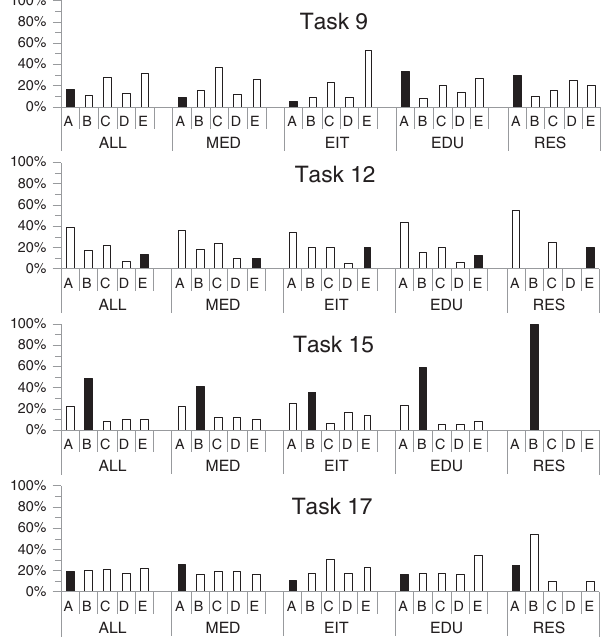
FIG. 8. The students ’ responses to the tasks grouped by the thermal internal energy of a gas concept concerned. For a detailed description see Fig. 1.